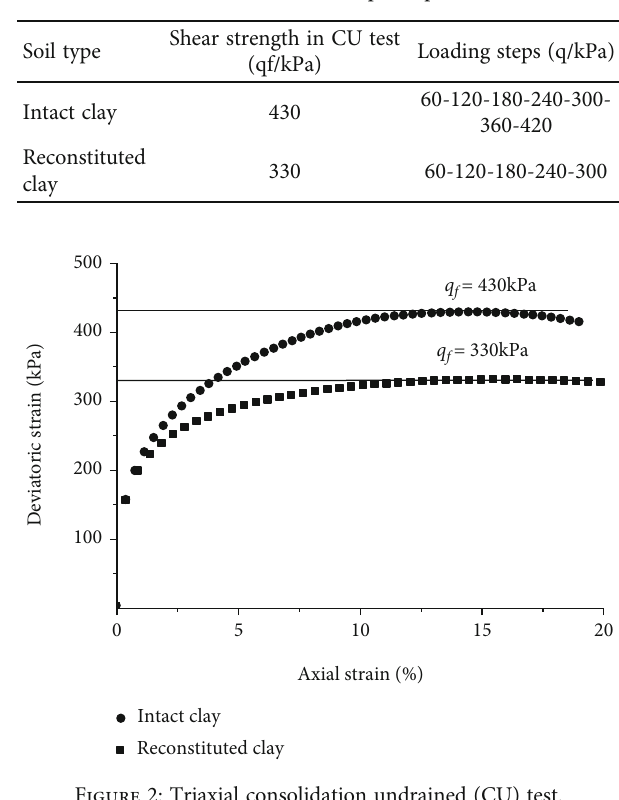
Table 2: Triaxial creep test